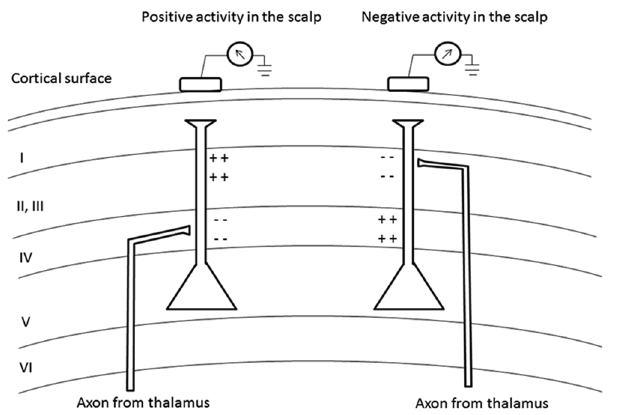
Figure 1. Generation of extracellular voltage fields. Relationship between the polarity of surface potentials and the location of dendritic postsynaptic potentials. EPSP depolarizing cell membrane induces a local negative local field potential (- -) and a positive local field potential (+ +) far away from the source. EPSP can also induce negative or positive activity in the scalp depending on the cortical layers